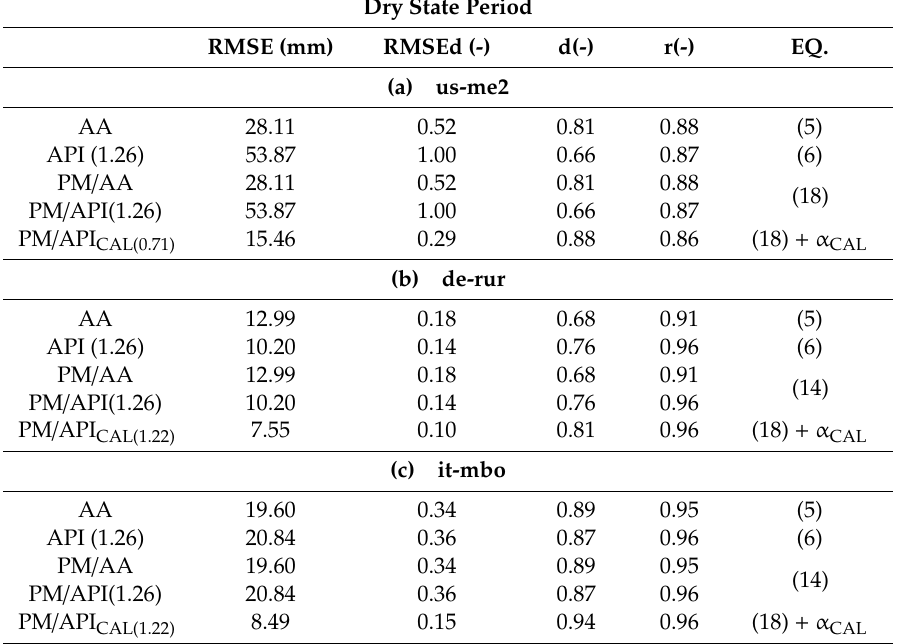
Table 5. Goodness-of-fit indices for the four applied models. Errors are computed on monthly AET time series for the dry state period (AA = the advection-aridity method; API (1.26) = the API corrected potential evapotranspiration with α = 1.26; PM / AA = the Penman / advection-aridity threshold model;